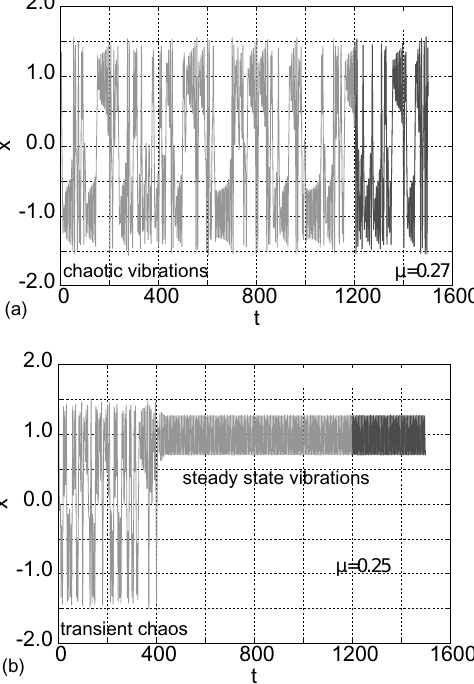
Fig. 6. Time histories for δ = − 1 , γ = 1 and µ = 0 . 27 (Fig. 6(a)), µ = 0 . 25 (Fig.